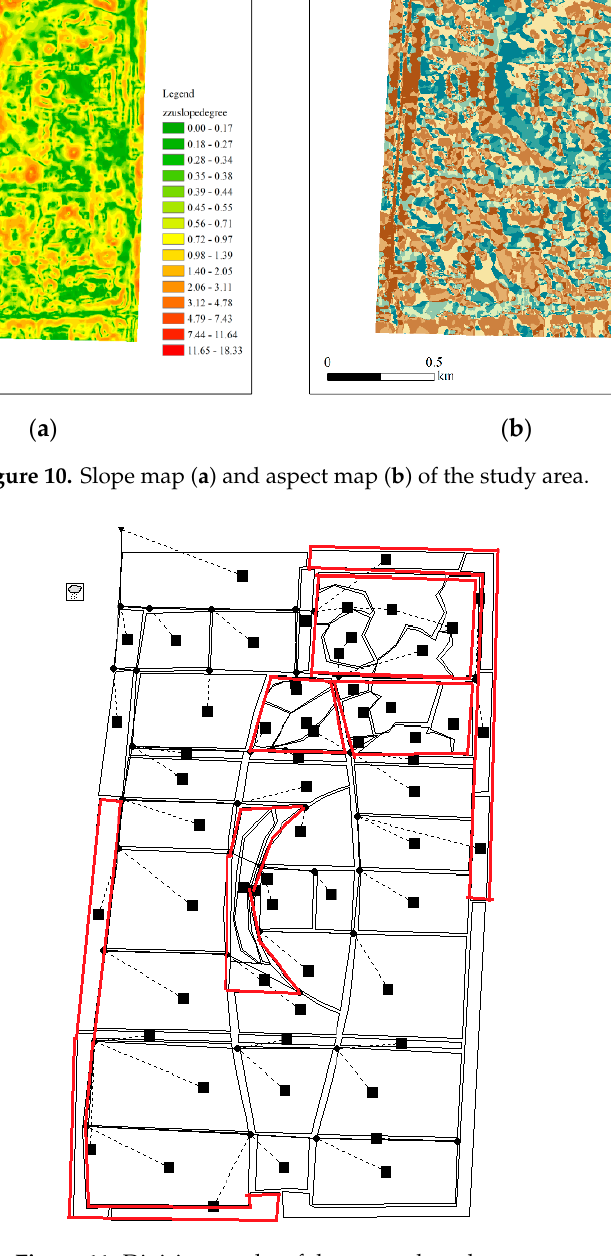
Figure 11. Division results of the new subcatchments.